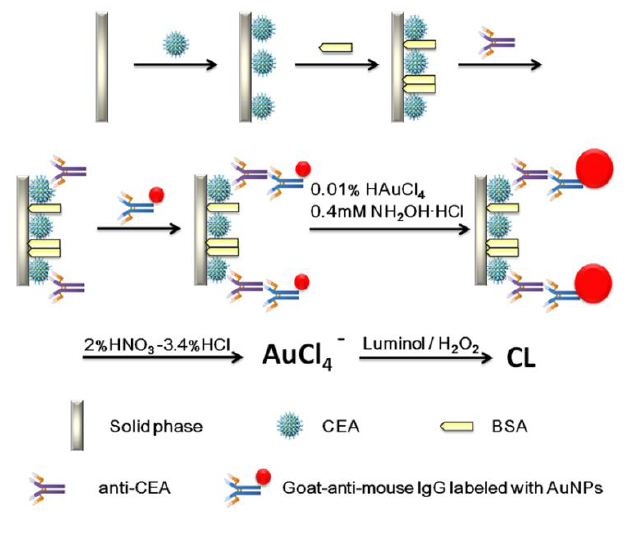
Scheme 1. Picture representation of the proposed CL immunoassay and colloidal